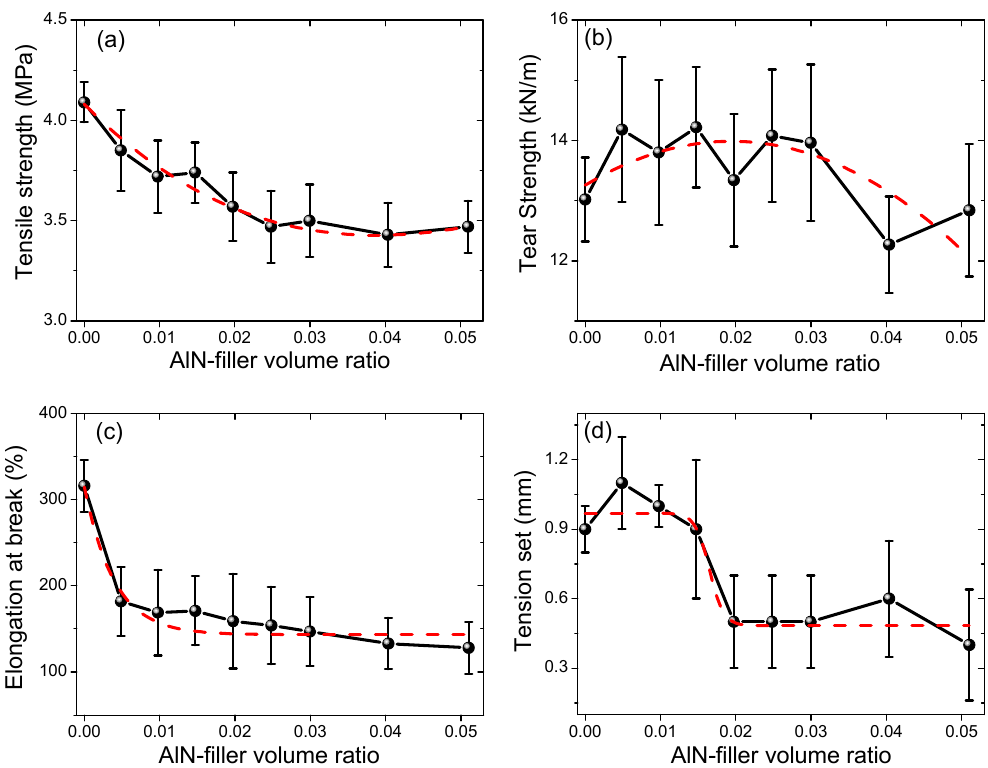
Figure 4. ( a ) Tensile strength, ( b ) tear strength, ( c ) elongation at break, and ( d ) Tension set of the AlN-filled silicon rubber composite samples. The dashed lines in the figures are for eye-guidance.